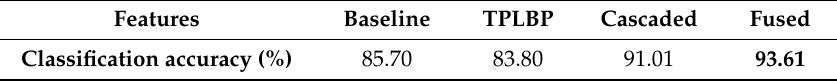
Table 4. The classification accuracy of different features.